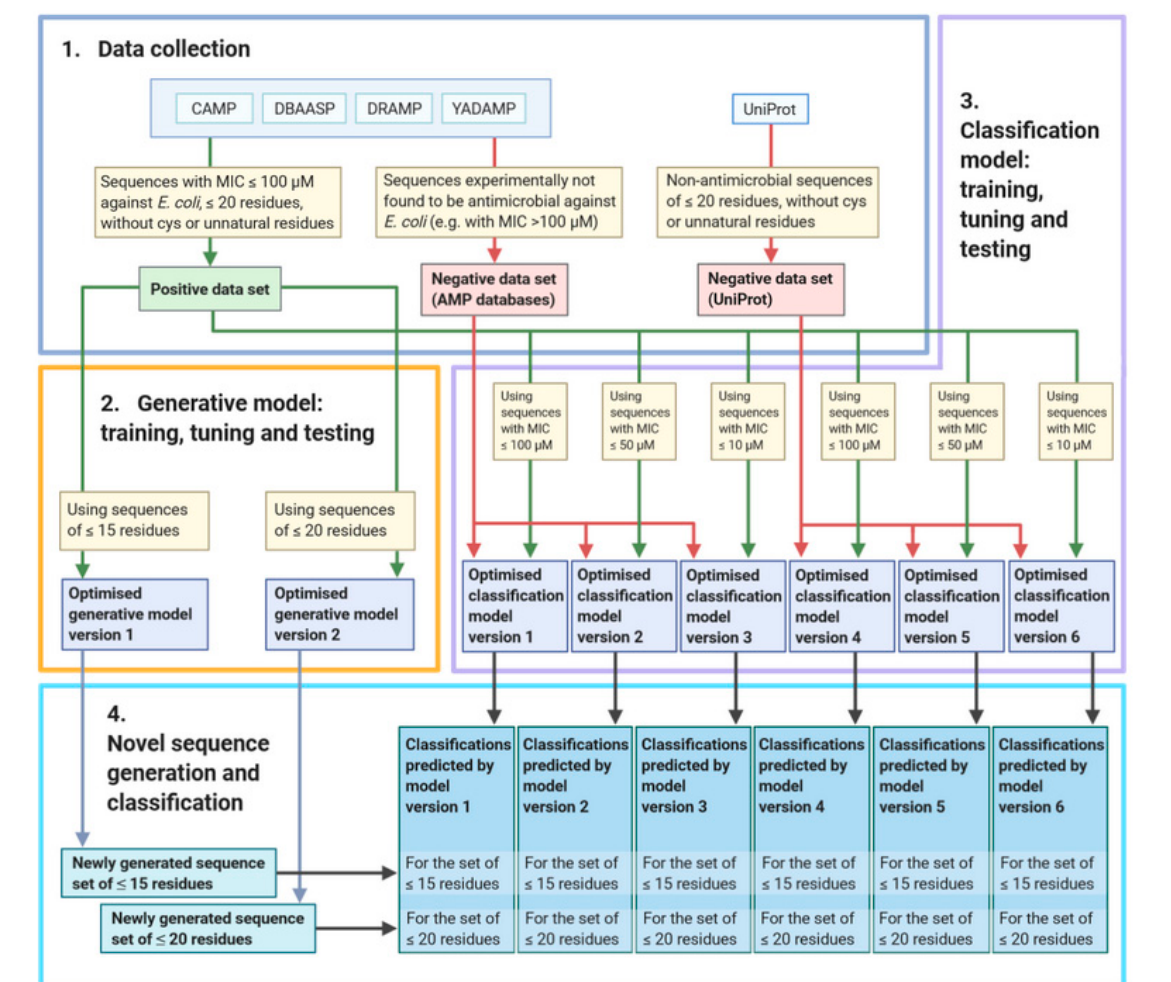
Figure 1. Workflow for the machine learning process. ( 1 ) Data for the positive set were collected from antimicrobial peptide (AMP) databases Collection of Anti-Microbial Peptides (CAMP), Database of Antimicrobial Activity and Structure of Peptides (DBAASP), Data Repository of Antimicrobial Peptides (DRAMP), and Yet Another Database of Antimicrobial Peptides (YADAMP). Two negative data sets were collected, from AMP databases and UniProt, respectively. ( 2 ) Two versions of the generative model were trained, tuned, and tested on the positive data set. ( 3 ) Six versions of the classification model were trained, tuned, and tested on the positive data set, as well as either the UniProt or AMP negative data set, using different minimal inhibitory concentration (MIC) cut-offs. ( 4 ) The optimised versions of the generative model ulti- mately produced two sets of AMP sequences. These sequences were then classified by the six optimised versions of the classification model, resulting in 12 sets of predictions.